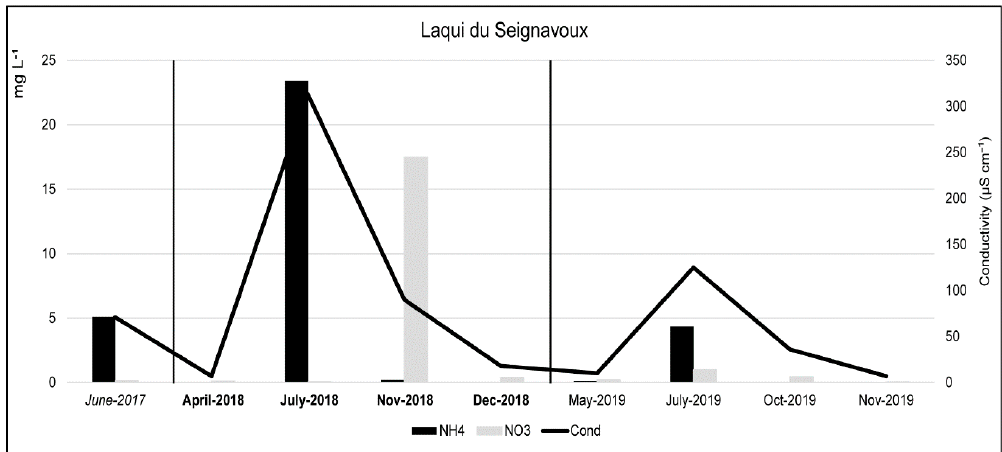
Figure 4. Concentrations of ammonium (mg L − 1 ), nitrate (mg L − 1 ), and conductivity (µS cm − 1 ) measured in Laqui du Seignavoux for each campaign in 2017, 2018, and 2019.